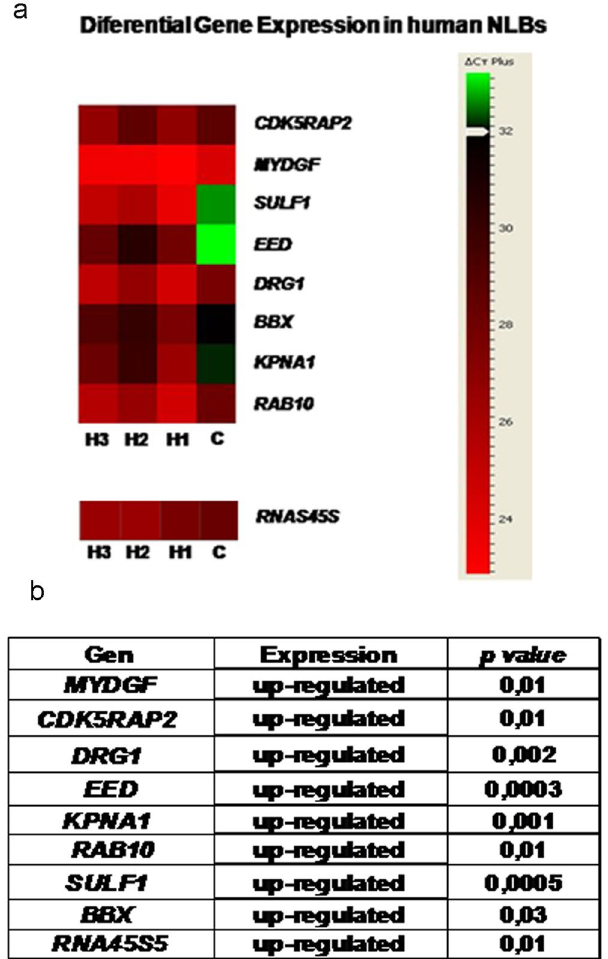
Figure 3. Differential gene expression in HSCR-NLBs versus Control-NLBs. ( a ) The Heat map was generated using DataAssist v3.0 software (Life Technologies) and it represents the messenger RNA expression levels of 9 genes expressed in colon tissue from HSCR patients and controls. Genes were hierarchically clustered by Pearson correlation coefficient using average linkage. The color scale, representing Δ Ct, is shown on the right side. Green indicates genes with relatively decreased expression in HSCR, whereas red indicates genes with relatively increased expression in HSCR compared with the controls. Ct, cycle threshold; Hirschsprung patiens (H); Control (C). ( b ) Table showing the variations in the gene expression levels in the NLBs from HSCR patients compared with